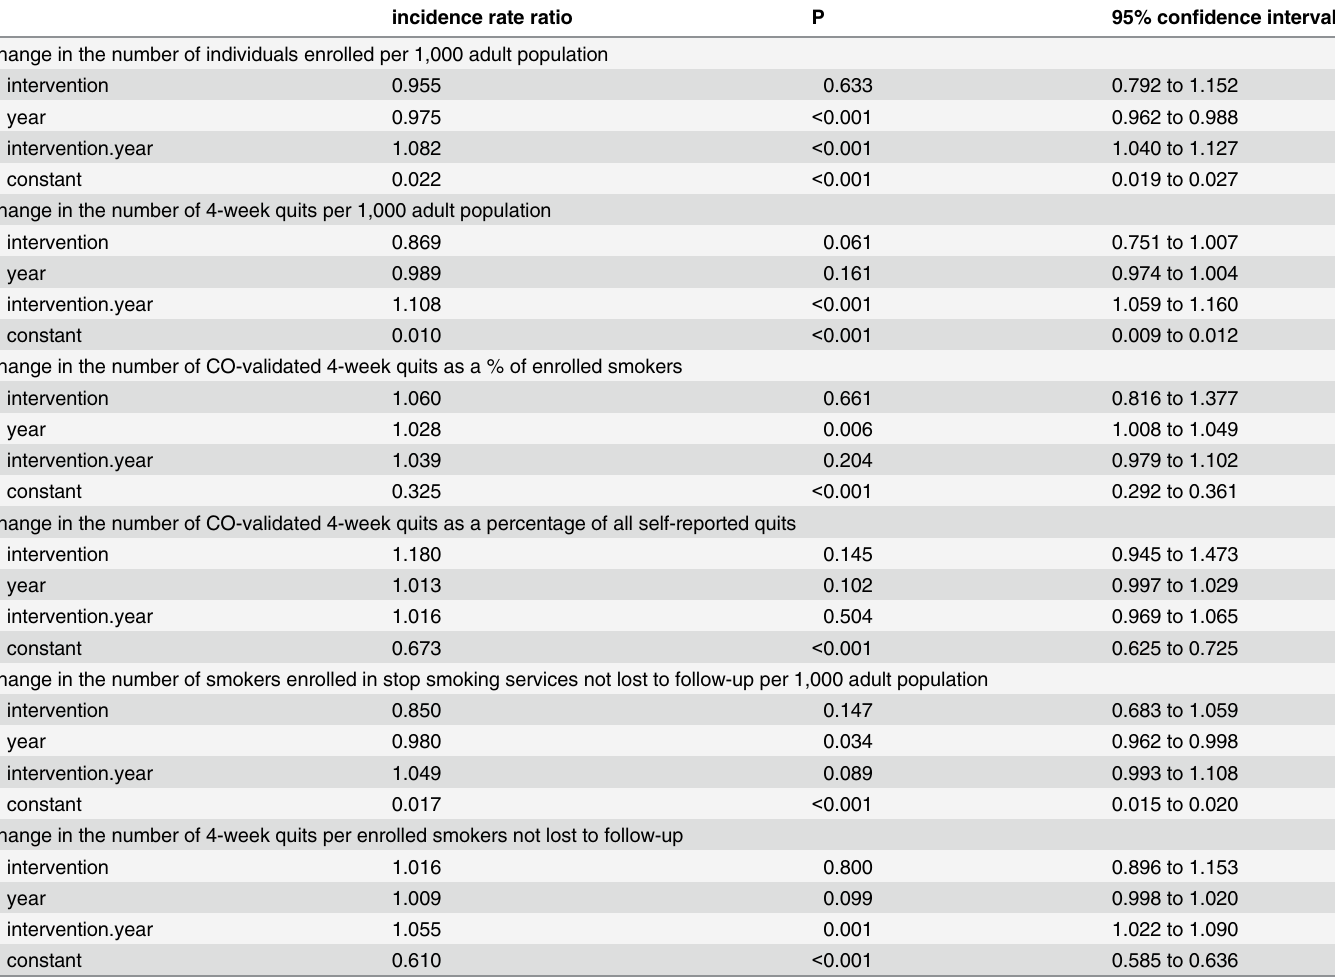
Table 2. intervention and control PCTs, changes between 2009/10 and 2012/13: model